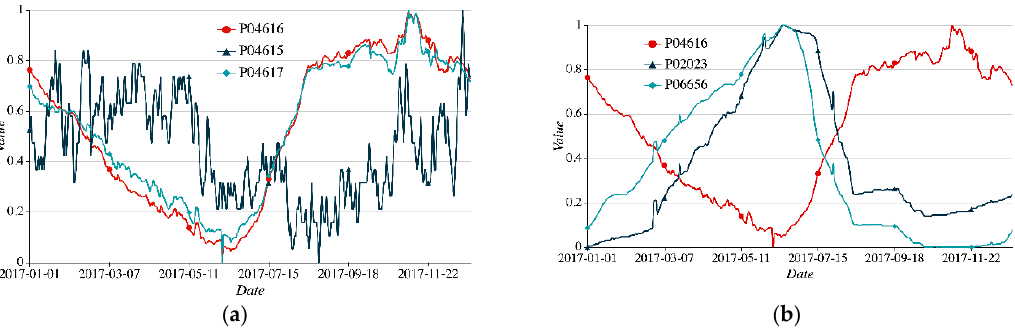
Figure 2. Illustrations of sensor readings of dam deformation data. ( a ) Densely-deployed sensors; ( b ) loosely-deployed sensors.